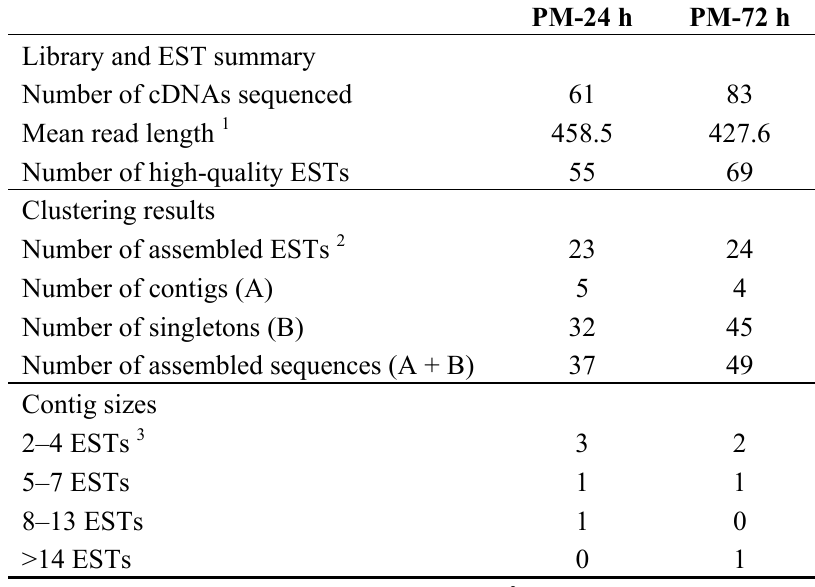
Table 1. General characteristics of the subtractive suppression hybridization (SSH)